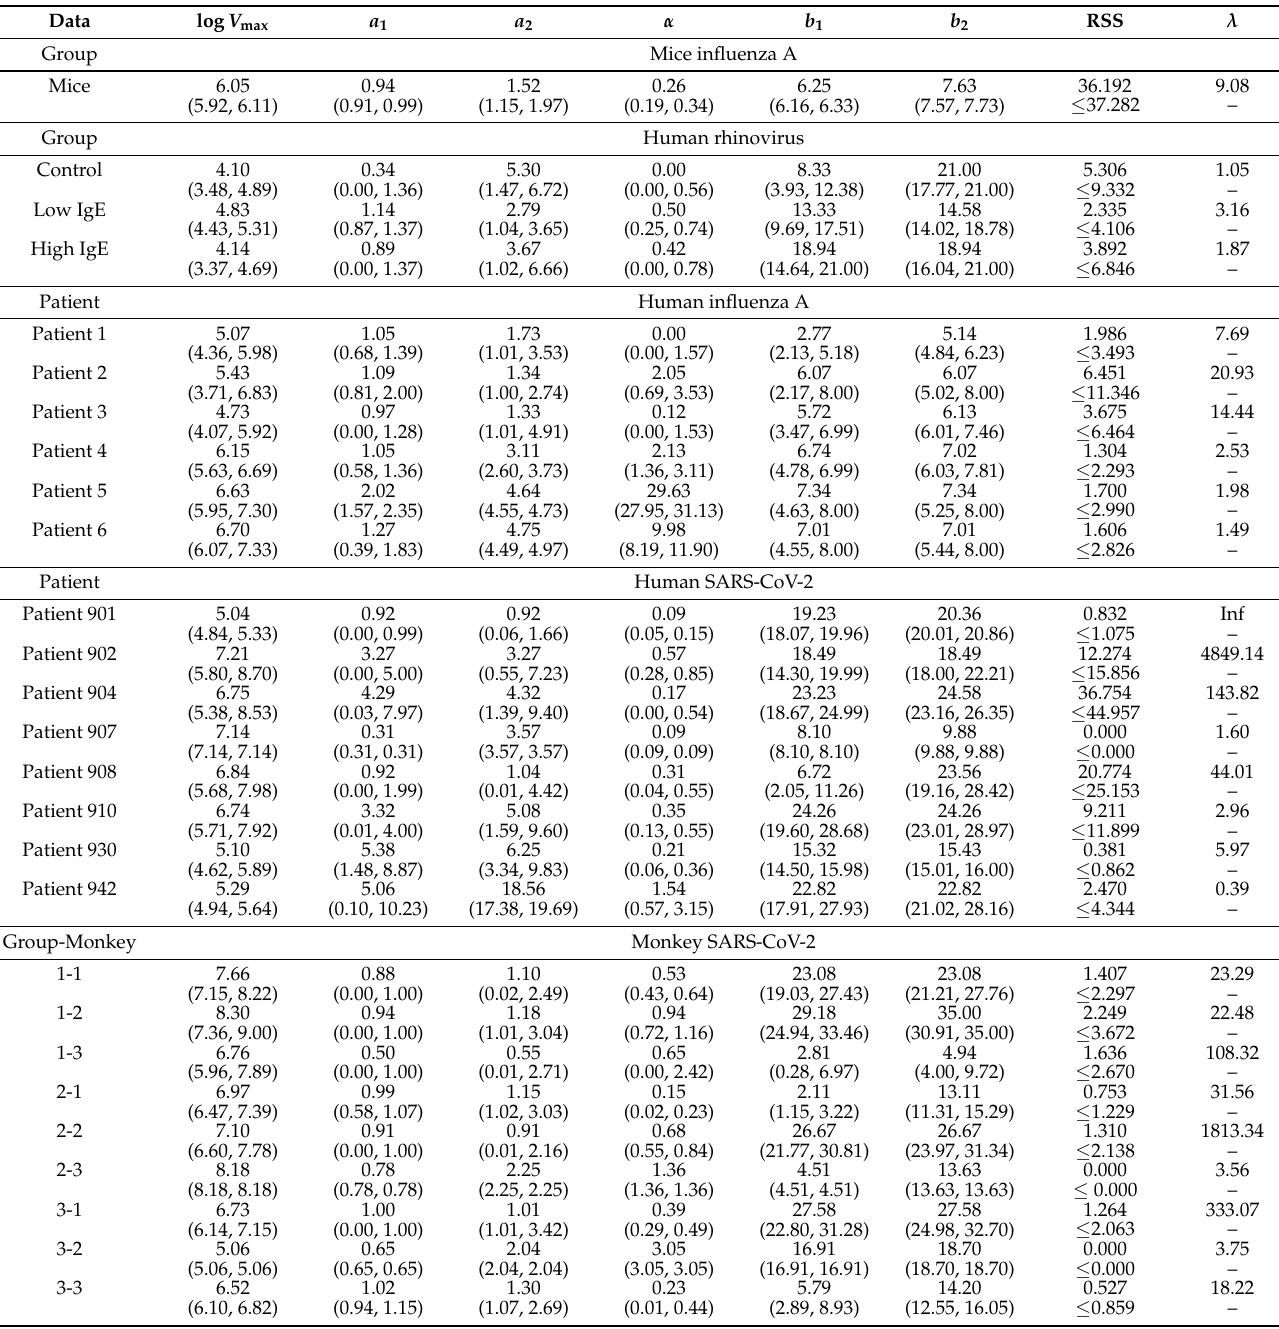
Table A1. Estimated parameter values corresponding to data fitting in Figures 5–8. For each subject, the first row is the best estimate, and the second row corresponds to the likelihood intervals. The RSS column shows the minimum RSS value and the maximum tolerance, respectively. The λ column shows the approximate slope of Phase I, according to